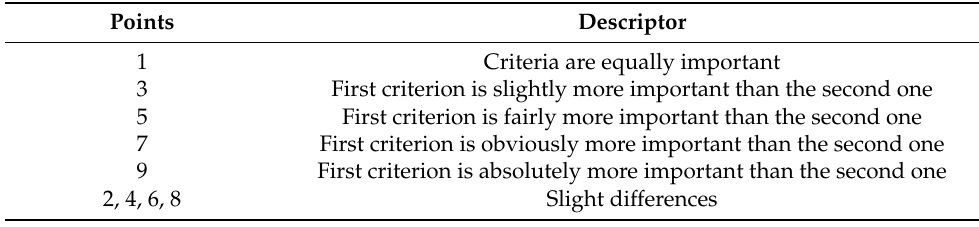
Table 3. Descriptors according to Saaty’s method (Source: Own elaboration,